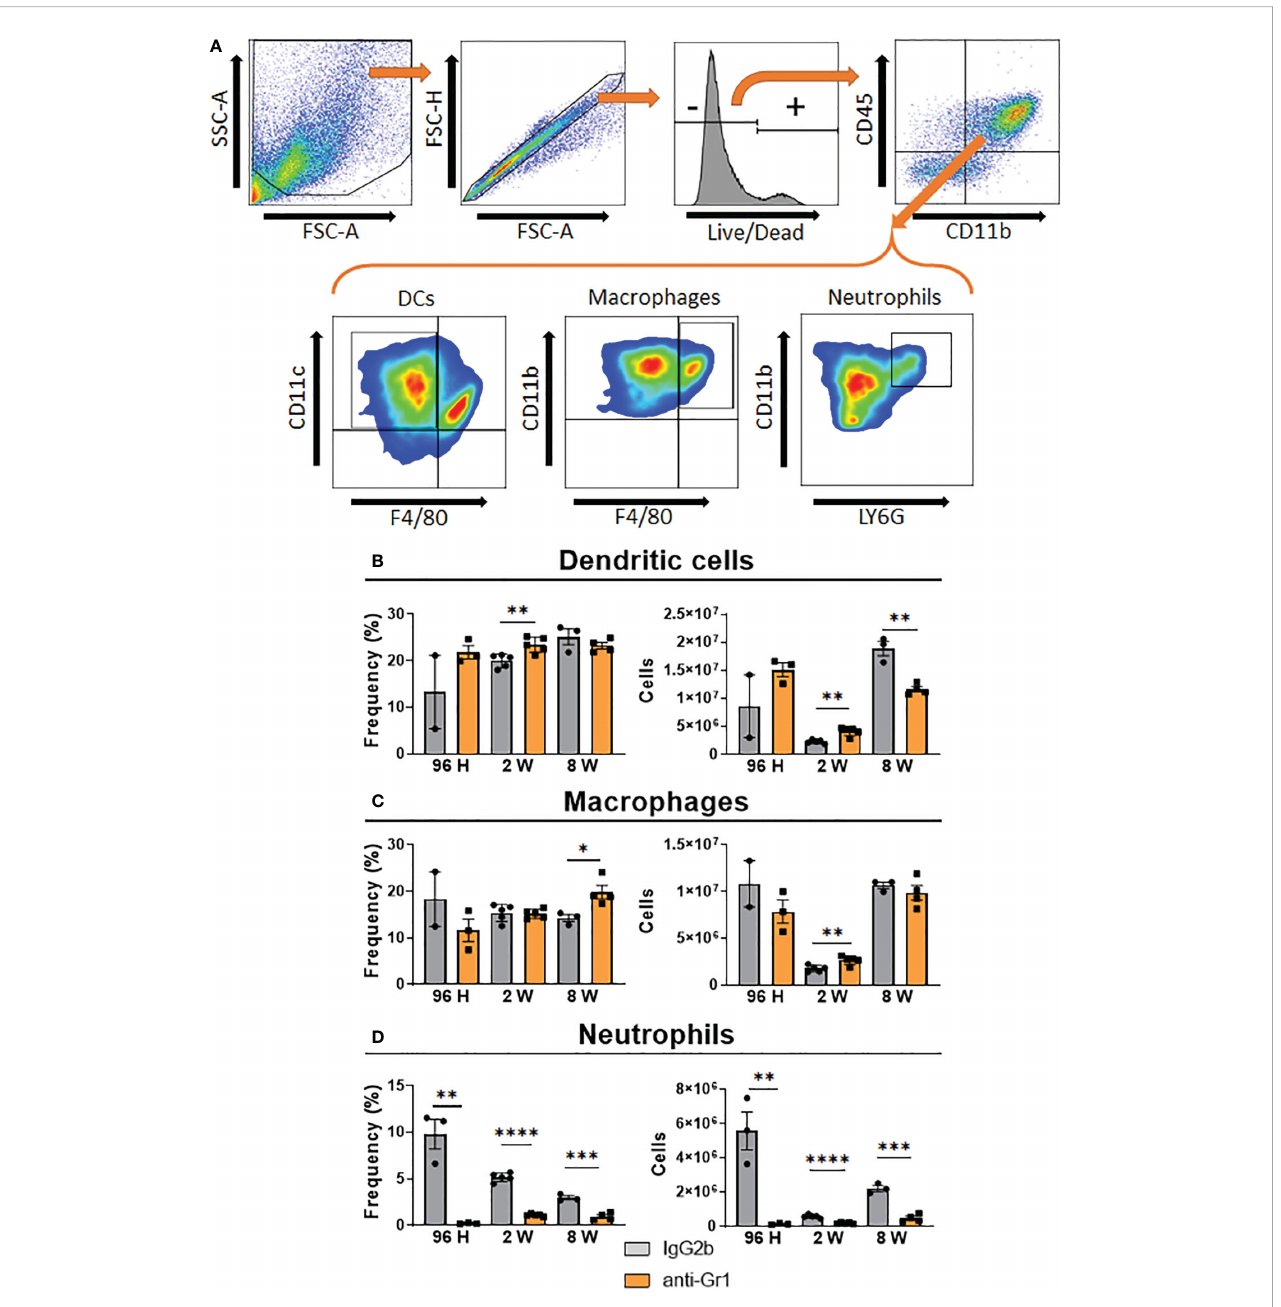
FIGURE 6 Effect of MDSC depletion in the presence of pulmonary myeloid cells of P. brasiliensis -infected mice. The frequency and the absolute number of pulmonary myeloid cells were evaluated in the lung-in fi ltrating leukocytes of anti-Gr1-treated and untreated infected mice. After 24 hours, 1 week, and 7 weeks of infection a group of mice received intraperitoneal injections of anti-Gr1 antibody (clone RB6-8C5) or rat IgG2b isotype control antibody (200 µg/dose). At 96 hours, 2 weeks, and 8 weeks of infection lungs were removed and leukocytes were obtained. The cells were gated by FSC/SSC analysis (A) and dendritic cells CD45 + CD11b + CD11c + F4/80 - (B) , macrophages CD45 + CD11b + F4/80 + (C) and neutrophils CD45 + CD11b + Ly6G hi (D) were analyzed by fl ow cytometry. Data represent three independent experiments with 3-4 mice each. For comparisons between two groups, the mean ± SEM was obtained and analyzed by the unpaired Student ’ s t -test. Differences were considered signi fi cant when: * p <0.05; ** p <0.01; *** p <0.001 and **** p